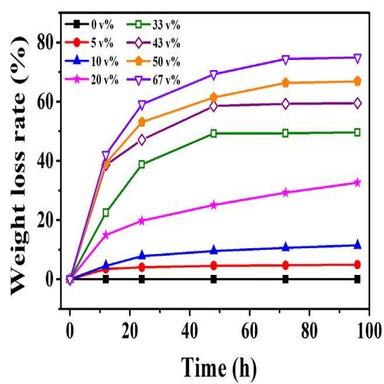
Weight loss rate of PVC films and PVC/CaCO3 composite films.